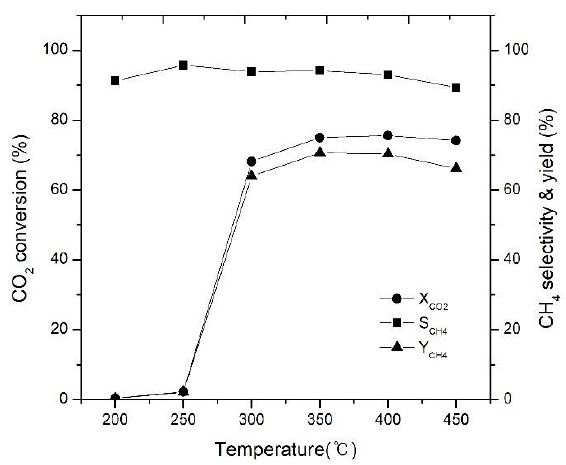
Figure 1. Effect of reaction temperature. Figure 1. E ff ect of reaction